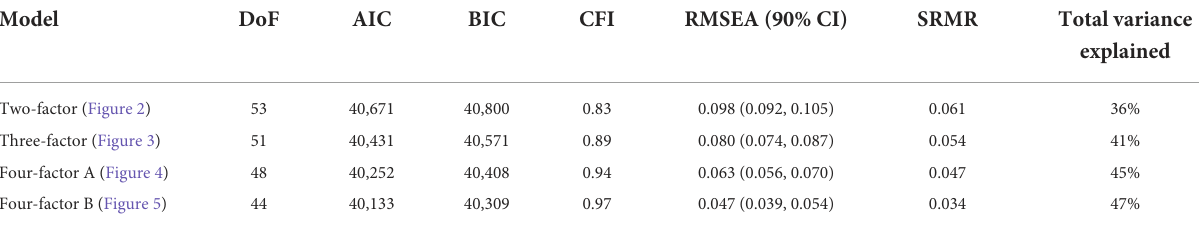
TABLE 5 Summary of CFA model fitting